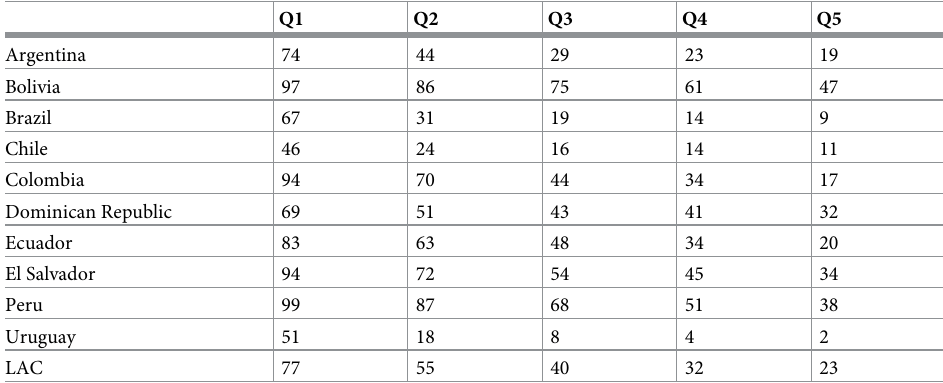
Note: Unweighted average for LAC. Data are from 2018 household surveys from Inter-American Development Bank–Harmonized Surveys for LAC, except Chile (2017). Income quintiles are calculated at the household level using monetary labor income per capita. LAC = Latin America and the